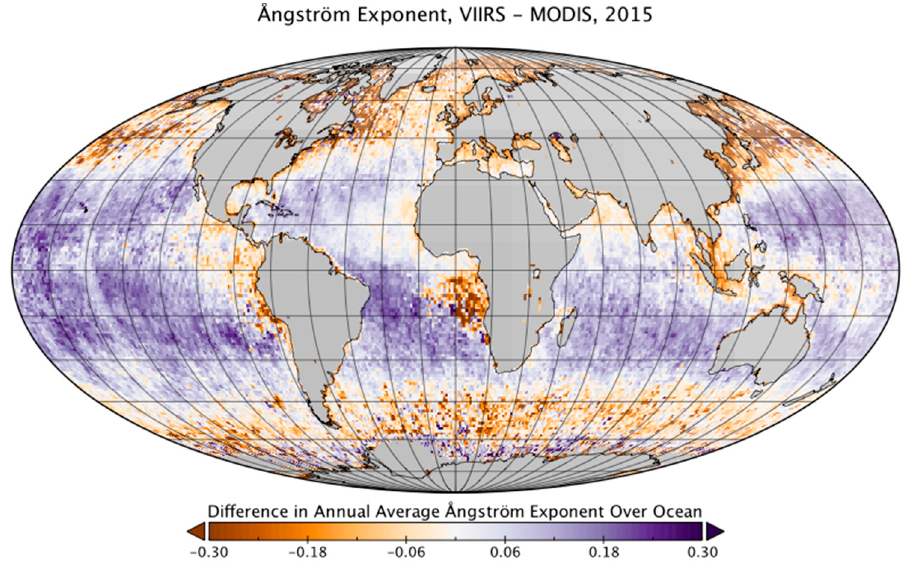
Figure 17. Difference between the Ångström exponent (calculated from the annual gridded average AODs at 0.55 μ m and 0.86 μ m) for VIIRS SNPP and MODIS Aqua. The global mean difference is 0.02.